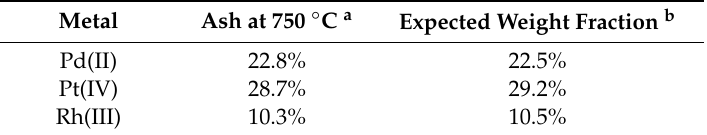
Figure 7. TG curves of the precipitates of ( a ) Pd(II) with n -nonylamine, ( b ) Pt(IV) with n -octylamine, and ( c ) Rh(III) with n -octylamine at a heating rate of 10 °C/min under air flow (200 mL/min). and ( c ) Rh(III) with n -octylamine at a heating rate of 10 ◦ C / min under air flow (200 mL / min). Table 1. Weight fractions after the combustion of the Table 1. Weight fractions after the combustion of the precipitates. Table 1. Weight fractions after the combustion of the precipitates.